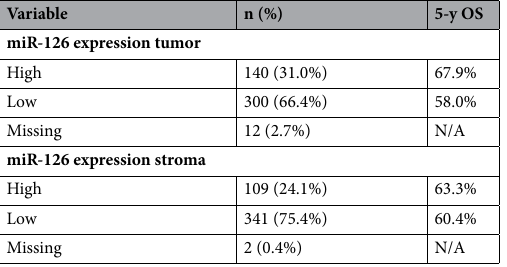
Table 1. Frequency table summarizing the median and range and total number of important continuous and cathegorical clinicopathological variables, respectively. For categorical variables five-year overall survival is given in percent.